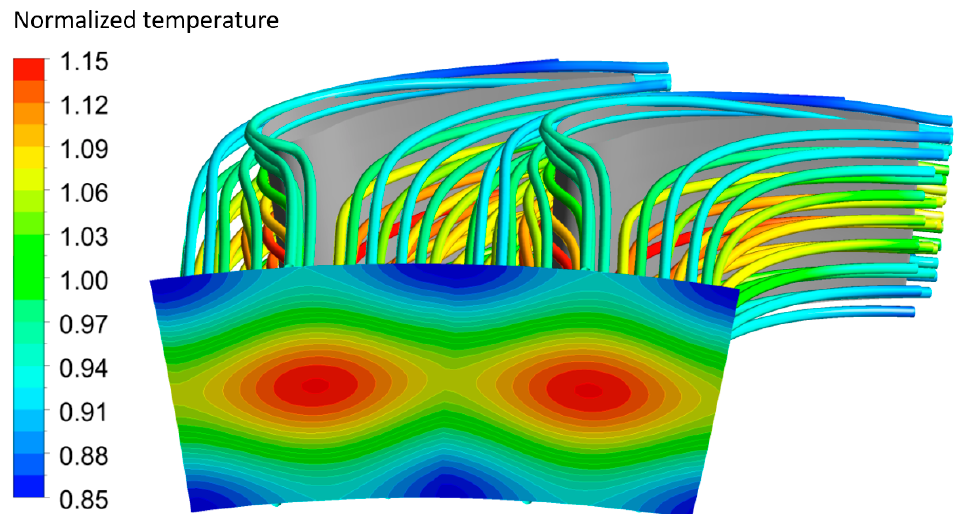
Figure 3. Contour of the temperature distribution at the turbine inlets with streamlines. The contour level is defined as the ratio of the actual temperature and the average temperature.